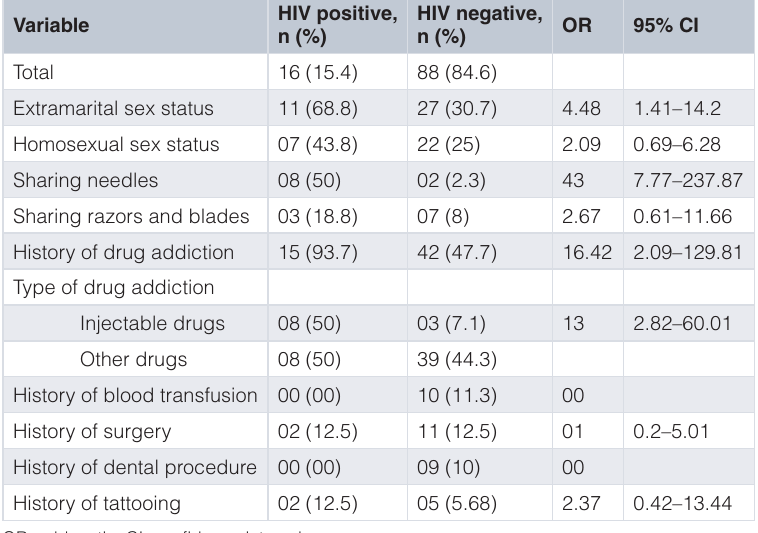
OR, odds ratio; CI, confidence